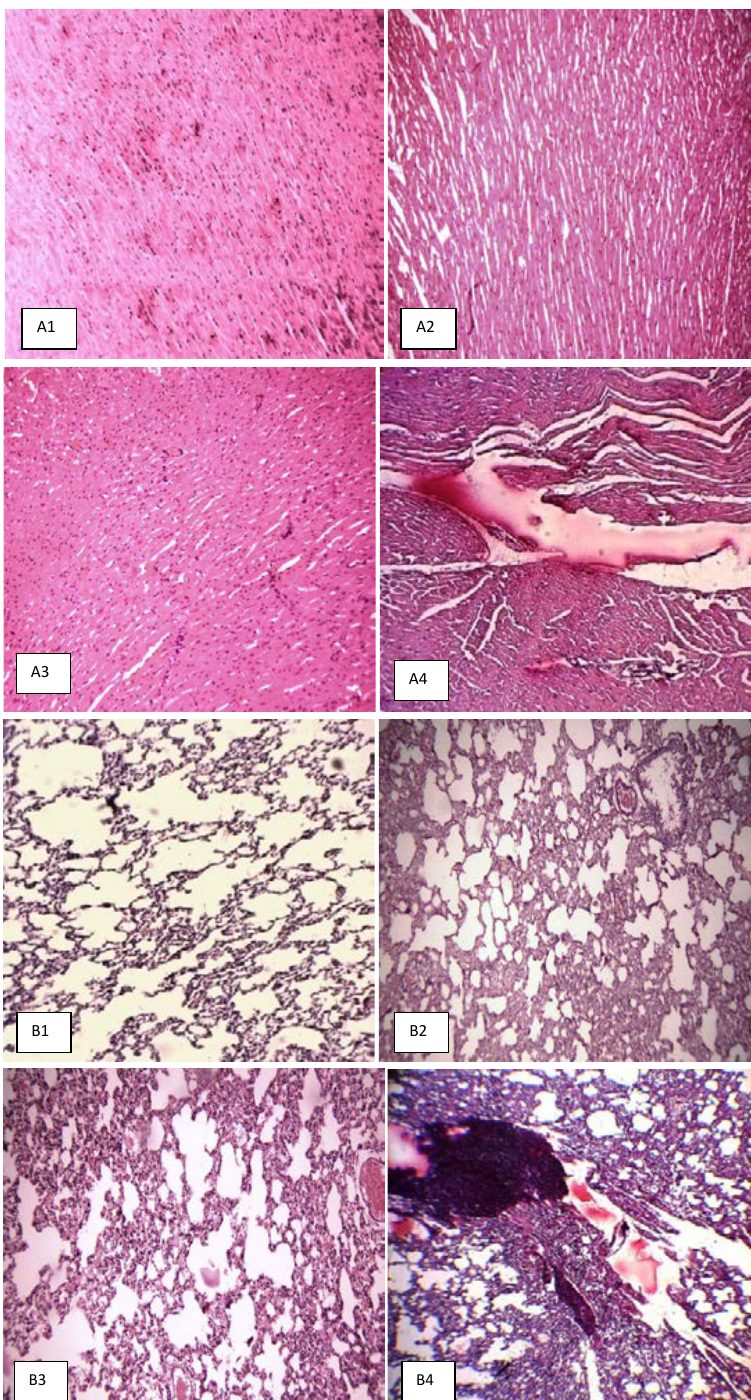
Fig. 2. Photomicrographs of heart, lung, liver and kidney sections obtained from rats exposed to different concentrations of NSPs. (A1, B1, C1, D1) control rats , (A2, B2, C2, D2) rats received 20 mg/kg of NSPs, (A3, B3, C3, D3) rats received 80 mg/kg of NSPs and (A4, B4, C4, D4) rats received 320 mg/kg of NSPs. Panels (A1, A2, A3): normal heart, A4: congestion, myocytolysis and edema in heart. Panels (B1, B2, B3): normal lung, B4: severe alveolar edema, hemorrhage and inflammation in lungs, Panels (C1, C2, C3): normal liver, C4: congestion and inflammation in liver. Panels (D1, D2, D3): normal kidney, D4: congestion and inflammation in kidney. (Staining with hematoxylin and eosin). Magnification: 100 x for